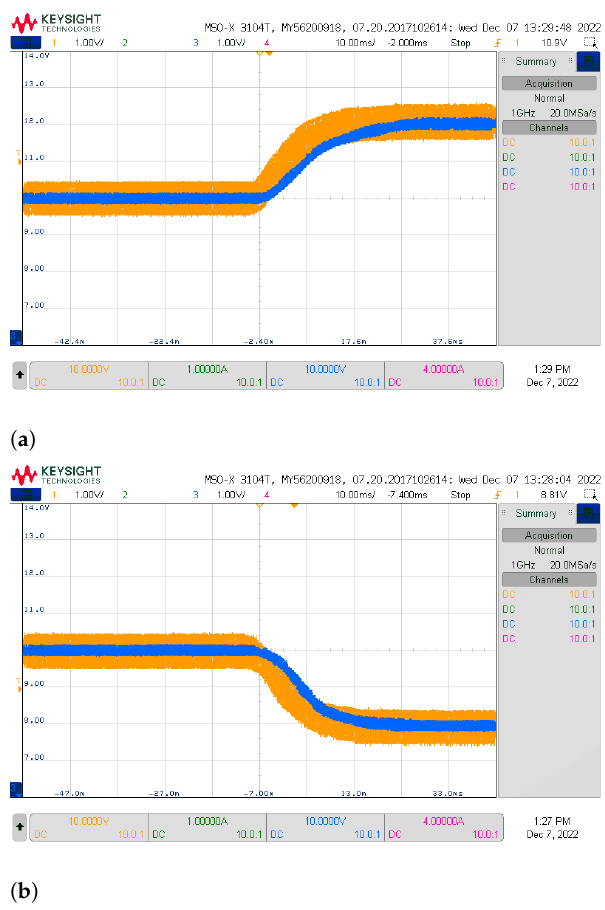
Figure 7. Dynamical response of the estimate ˆ E : ( a ) input voltage changes between 10 and 12 V; ( b ) input voltage changes between 10 and 8 V. CH1: (1 V/div); CH3: (1